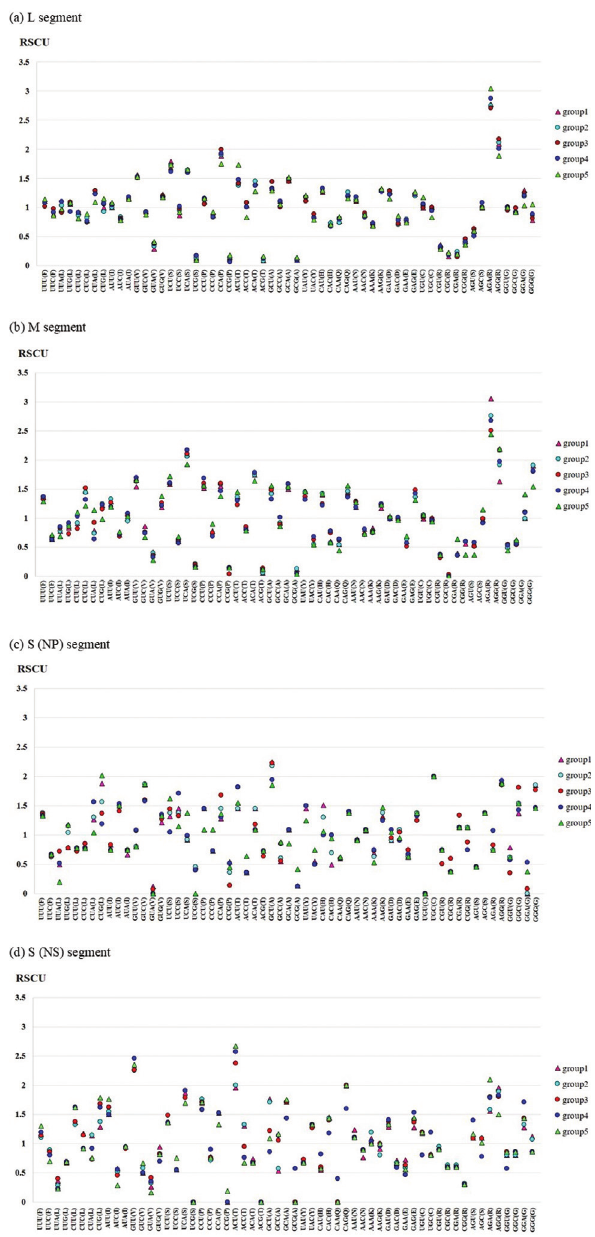
Figure 3 - RSCU analysis of RVFV segments; (a) L segment, (b) M seg- ment, (c) S (np) segment, (d) S (ns) segment There is more variation in the differences of codon preferences between groups in the S segment com- pared to the L and M